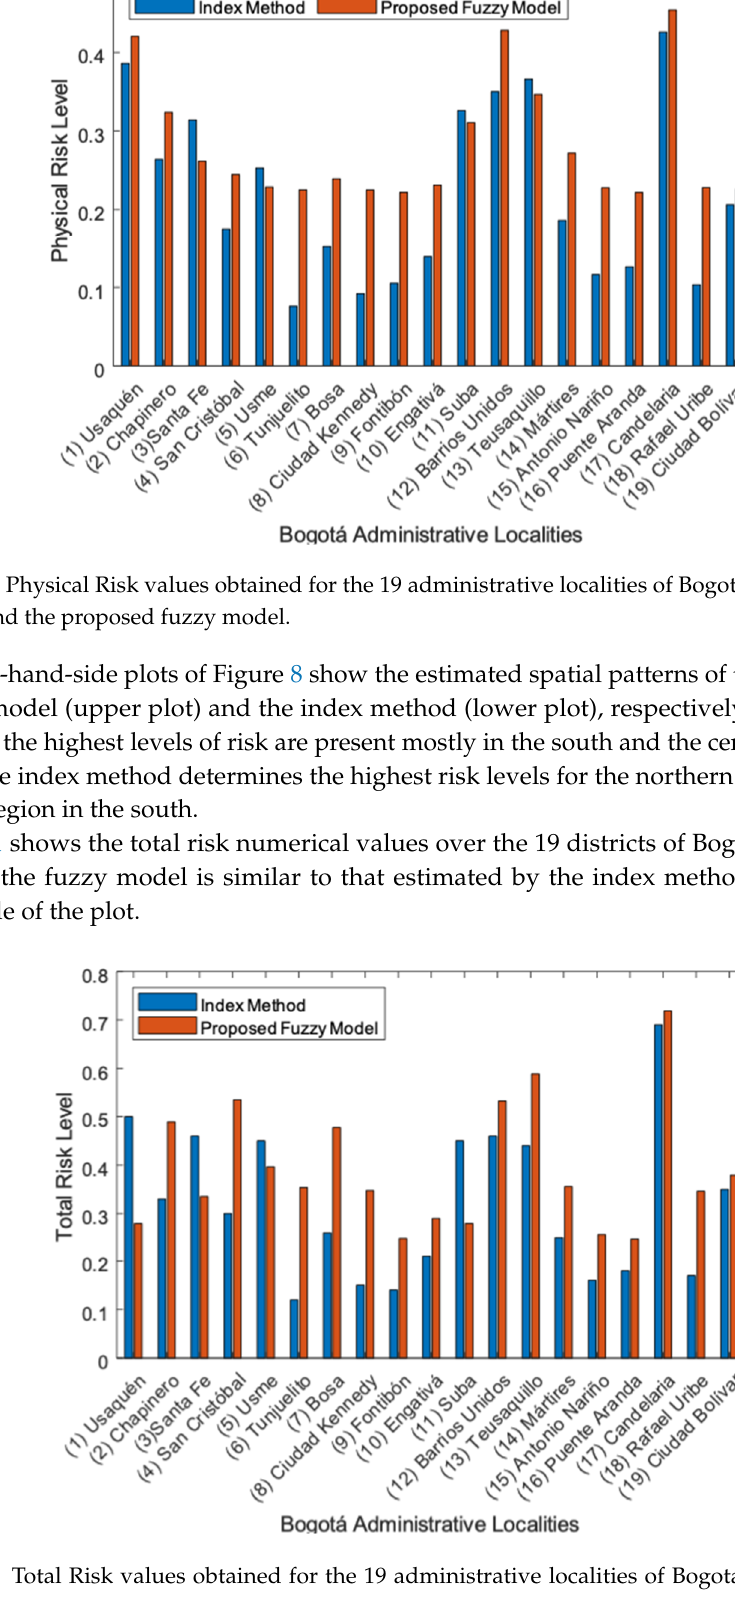
Figure 11. Total Risk values obtained for the 19 administrative localities of Bogotá with the index method and the proposed fuzzy model method and the proposed fuzzy